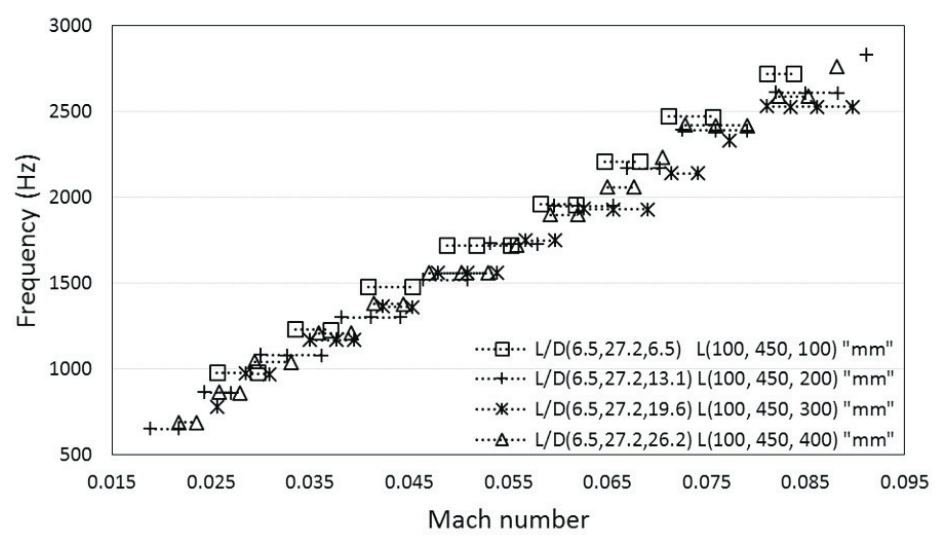
Figure 11. Frequency (Hz) plotted against Mach number M for L up = 100 mm, L corr = 450 mm, and L dw = 100–400